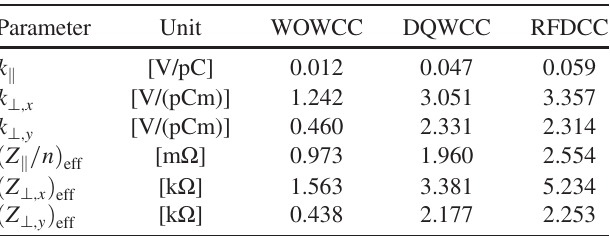
TABLE III. Loss factors and effective impedances.